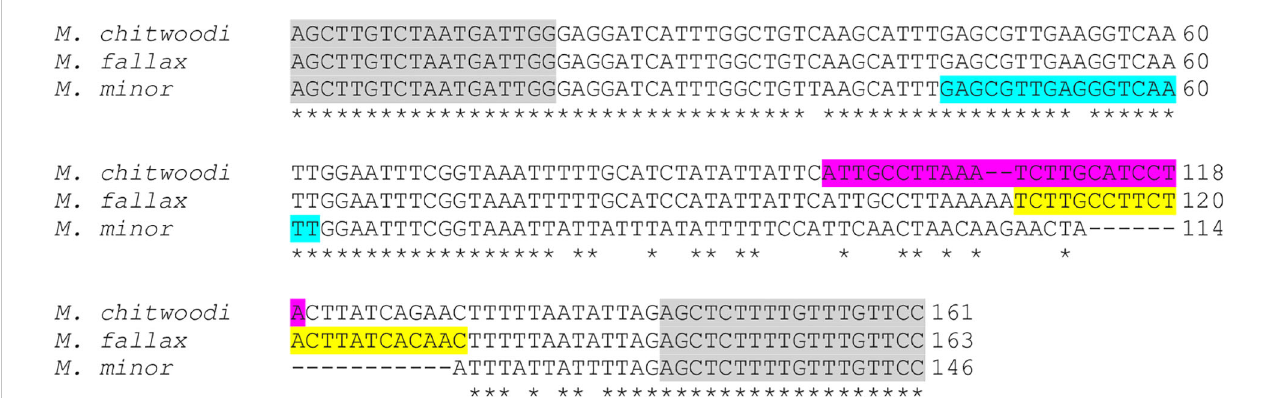
FIGURE 1 Alignment of partial HSP90 gene sequences for M. chitwoodi , M. fallax , and M. minor . Universal primer sequences are highlighted in gray. Variable regions targeted by the beacons are highlighted in teal for M. minor , magenta for M. chitwoodi , and yellow for M. fallax . Asterisks indicate conserved regions between all three species, gaps indicate missing nucleotides according to the